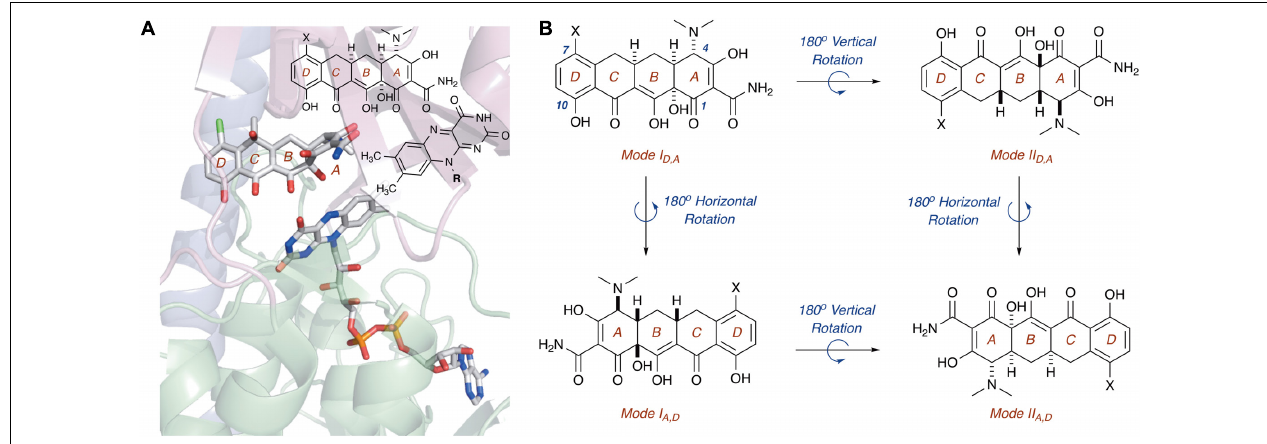
FIGURE 5 | (A) X-ray crystal structure of CTc bound to TetX in binding mode I D , A defines the orientation of FAD relative to each CTc binding mode (PDB ID: 2y6r). (B) Theoretical and experimentally observed tetracycline binding modes (four total). Image in panel (A) was generated using PyMOL v1.7.